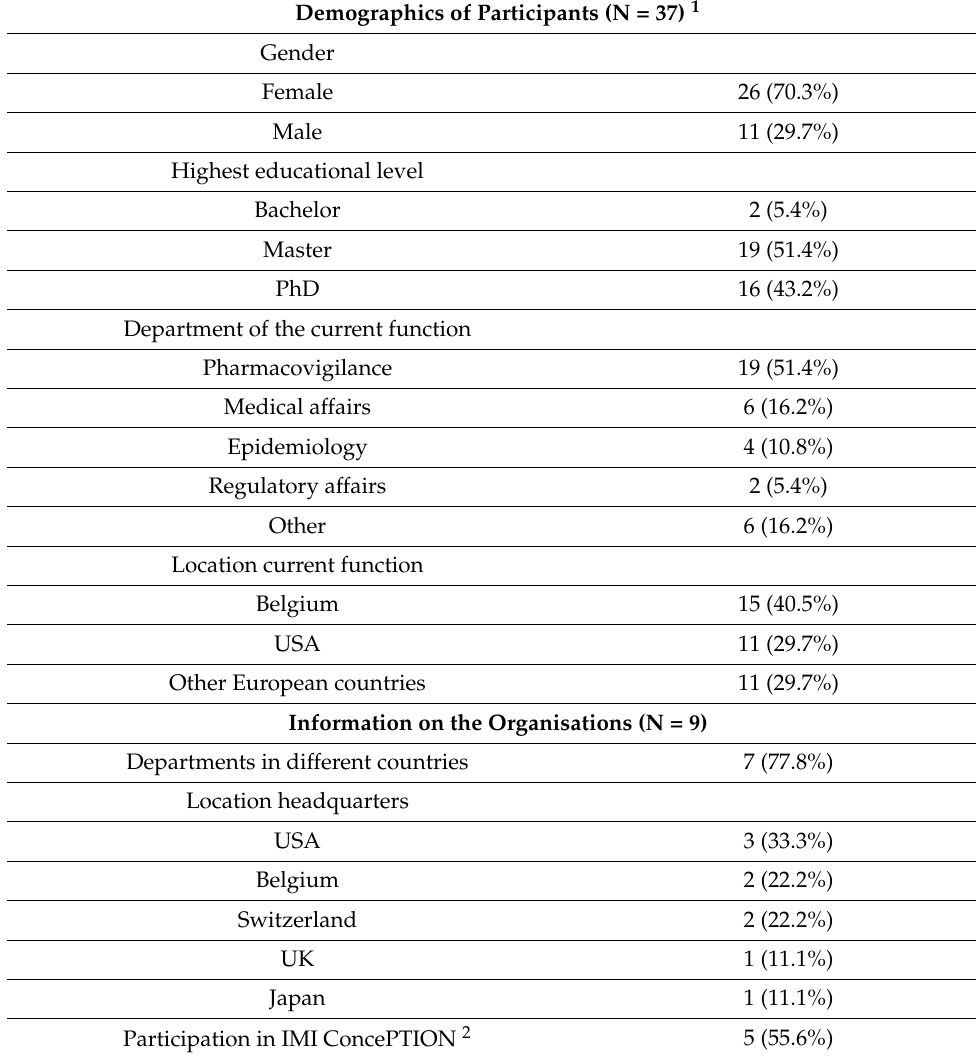
Table 1. Demographics of the participants and information about the